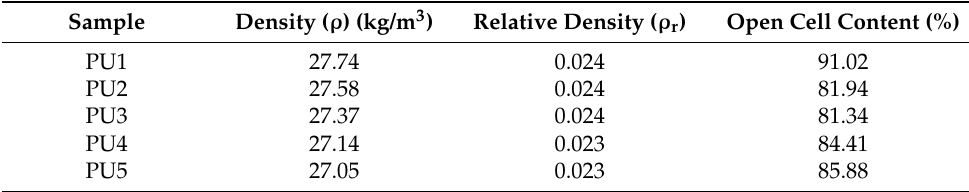
Table 1. Properties of the